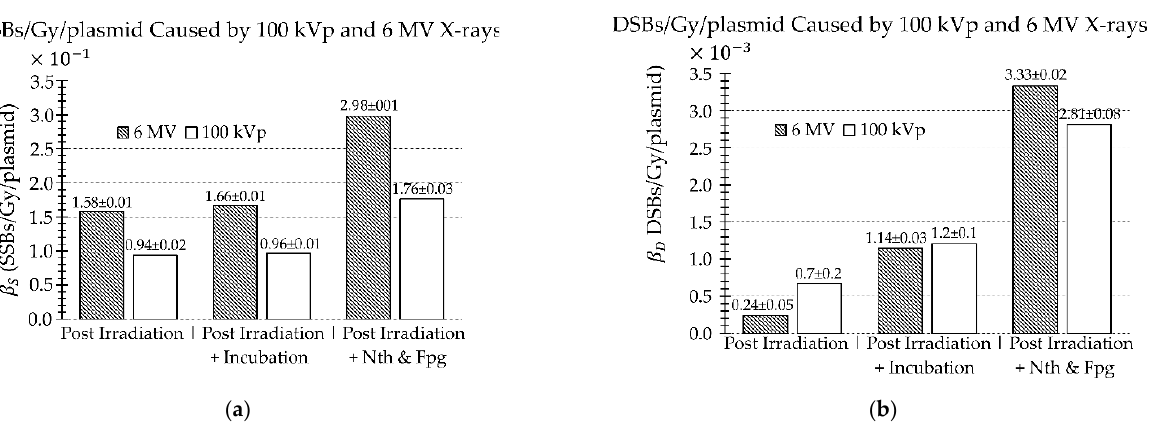
Figure 2. Comparison of the rates of ( a ) SSBs/Gy/plasmid and ( b ) DSBs/Gy/plasmid, caused by the 100 kVp versus 6 MV beam as measured post irradiation, post irradiation and incubation, and post irradiation and enzymatic treatment. Uncertainties represent 68% confidence intervals. Table 3. Types of DNA damage and corresponding probability parameters. Uncertainties represent 68% confidence intervals.